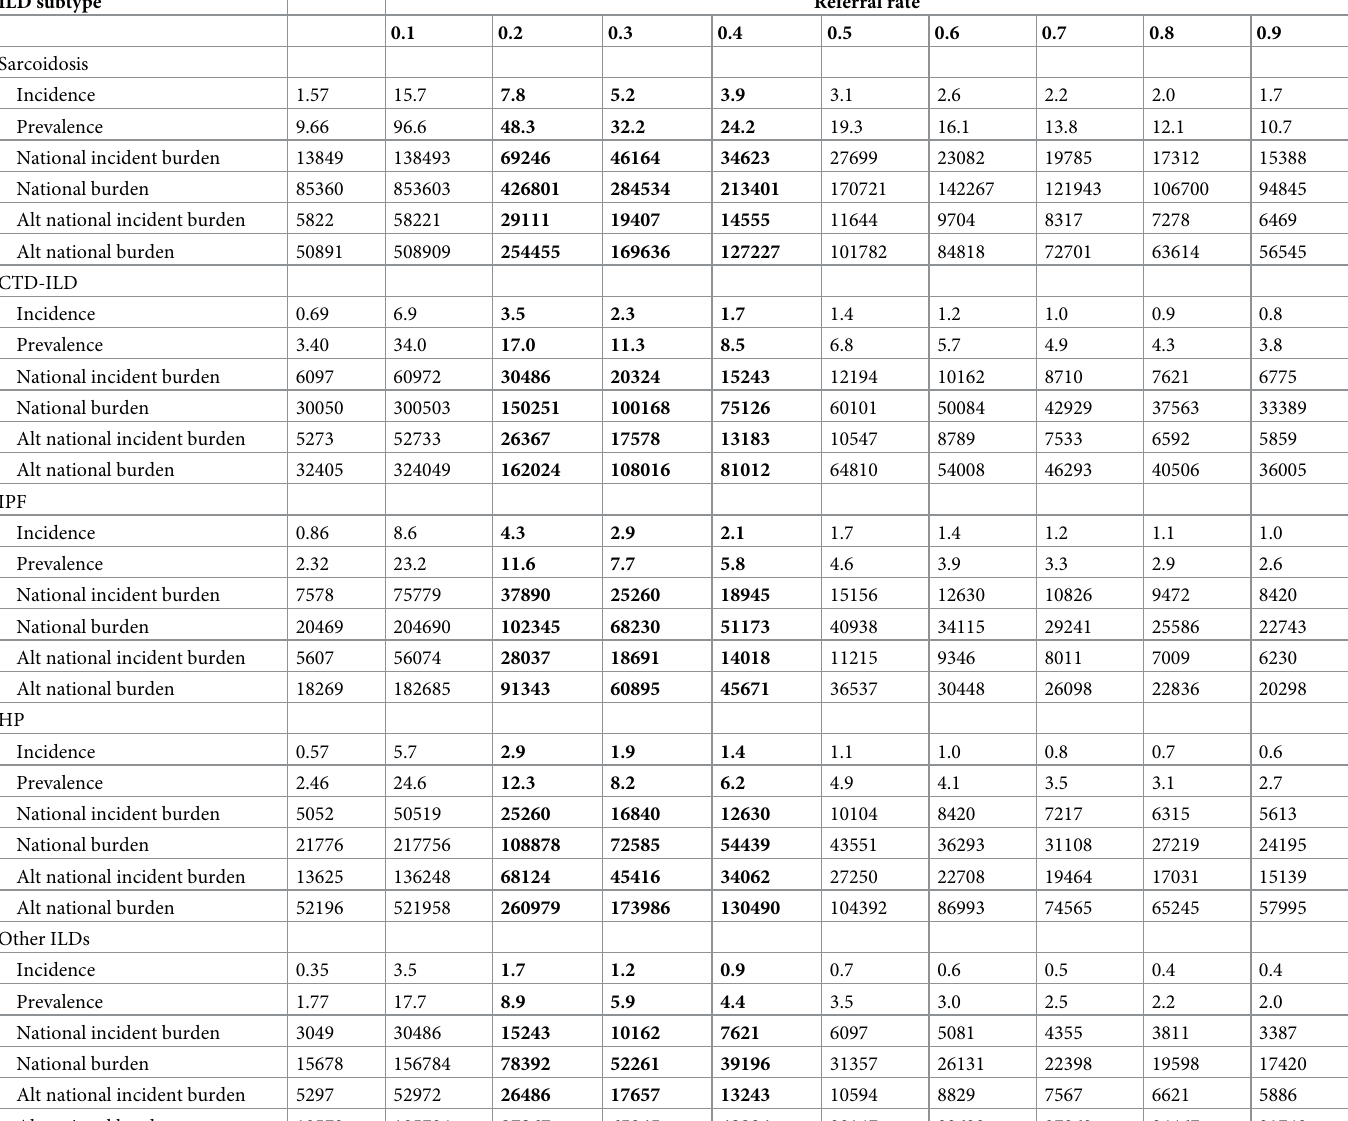
Table 6. Incidence and prevalence of various subtypes of interstitial lung diseases in the Tricity region and estimated national burden according to different assumptions of referral rates to our center. ILD